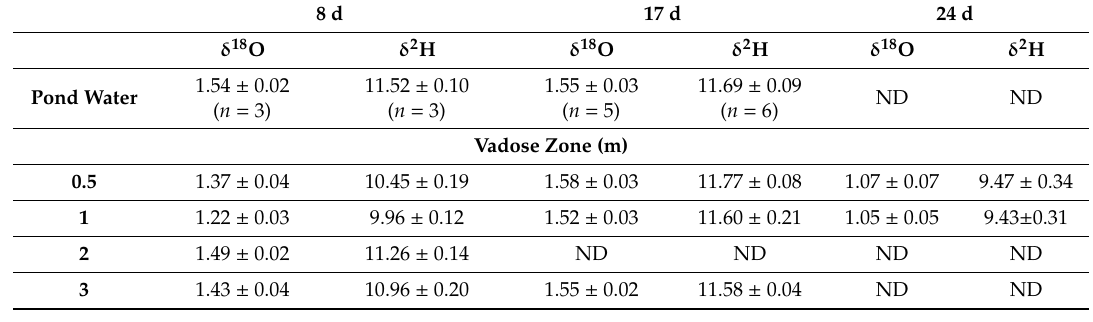
Table 4. Water isotopes (VSMOW, ‰ ) in the ponding water and vadose zone 4, 13, and 20 d after the infiltration began. Pond water samples were collected at multiple points (number of sampling points provided in brackets). (ND—No data.)